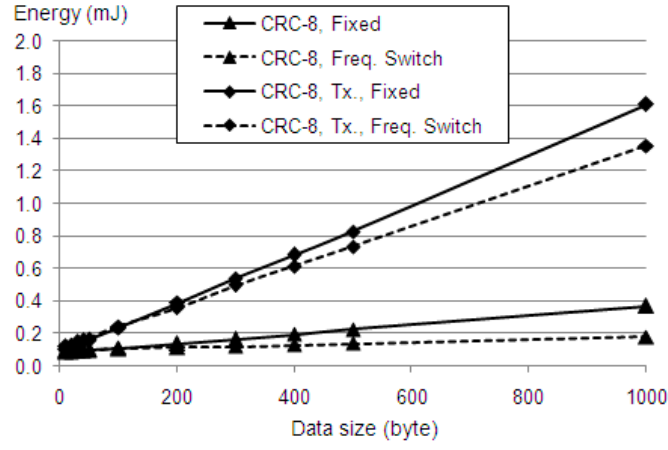
Figure 6 . Energy consumption of CRC - 32 versus data sizes .